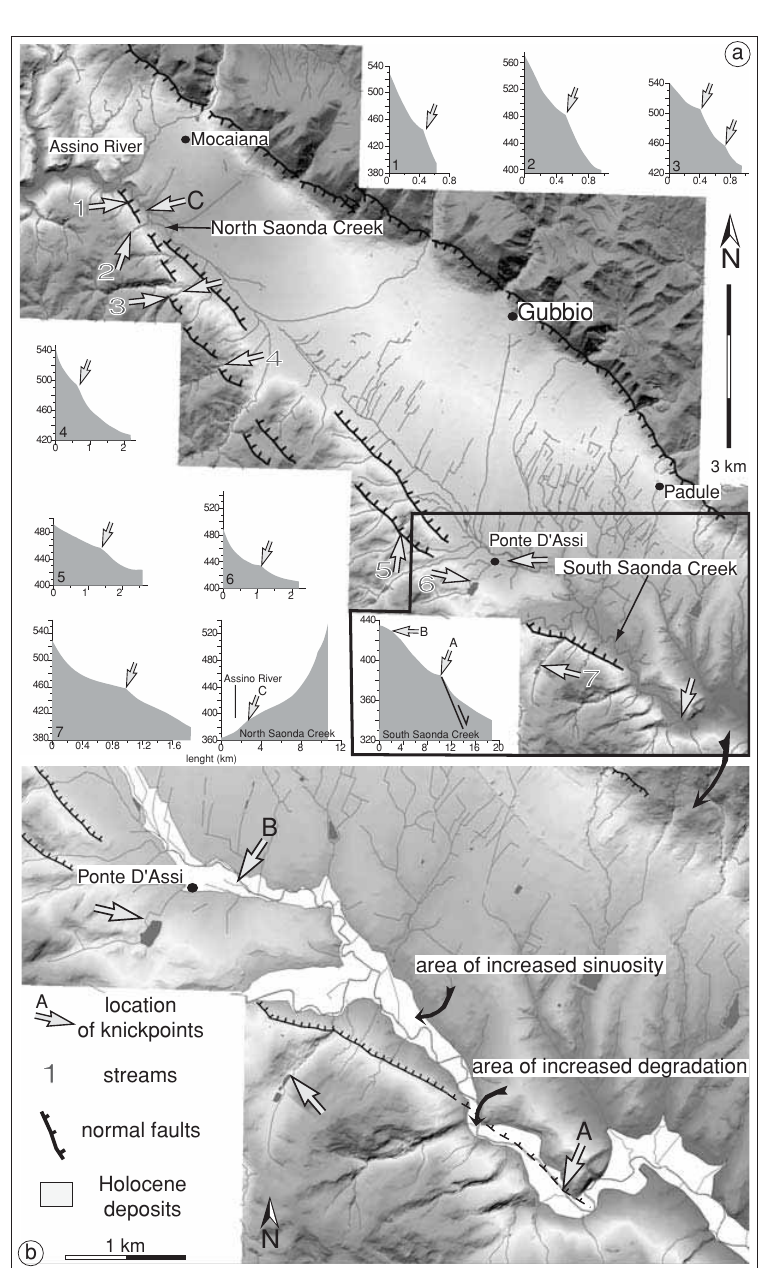
Fig. 10a,b. a) Longitudinal profiles of the western basin streams performed from 5 m resolution DEM with knick-points location; b) detail of the South Saonda Creek showing changing behavior running from the footwall to the hangingwall of a fault